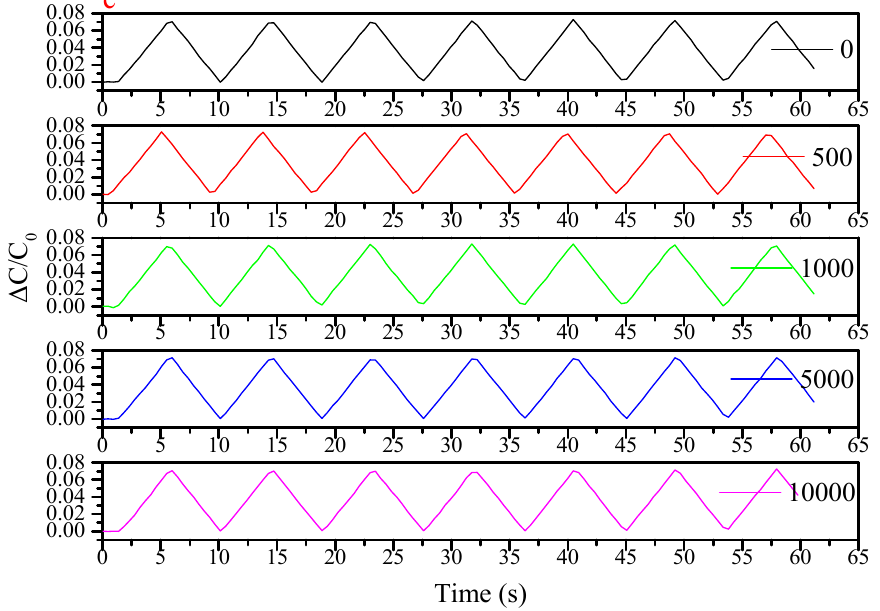
Figure A4. ( a ) Sensor record at the frequency of 0.5 Hz with 10% elongation at different times of the durability test; ( b ) at the frequency of 0.2 Hz with 10% elongation; ( c ) at the frequency of 0.1 Hz with 10% elongation.